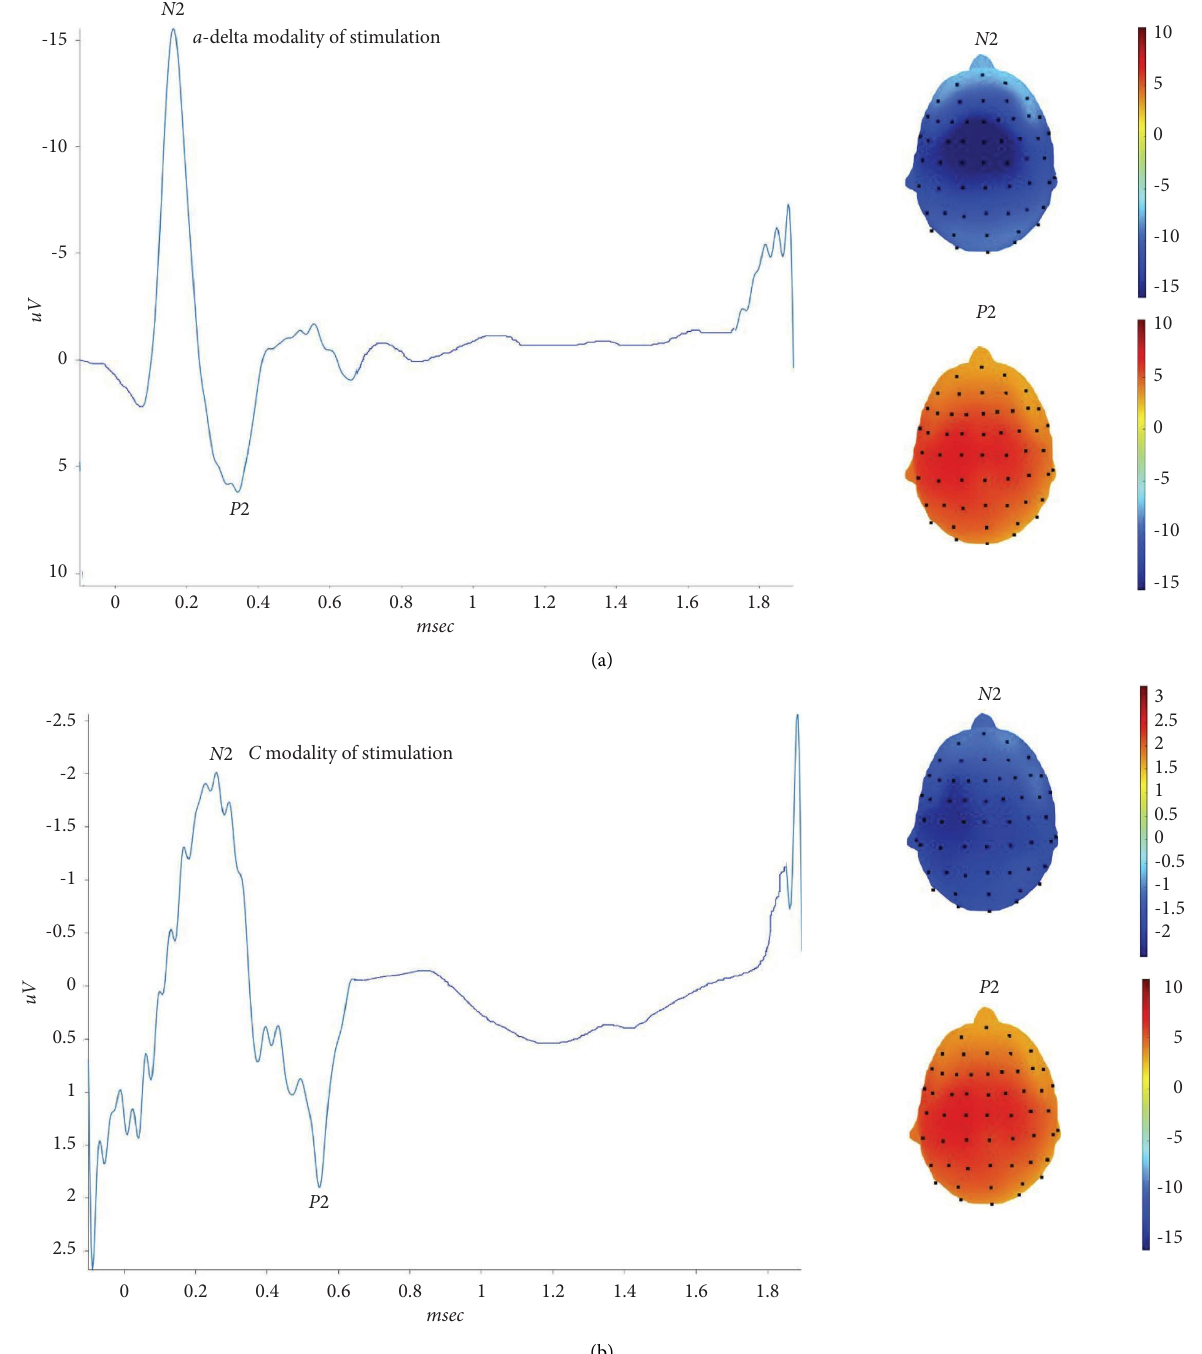
Figure 1: On the left side, the grand average of N2 P2 waves obtained by the right frst trigeminal branch stimulation are reported. On the right side, the corresponding topographical maps are represented. Upper: a-delta modality of stimulation. Lower: C-modality of